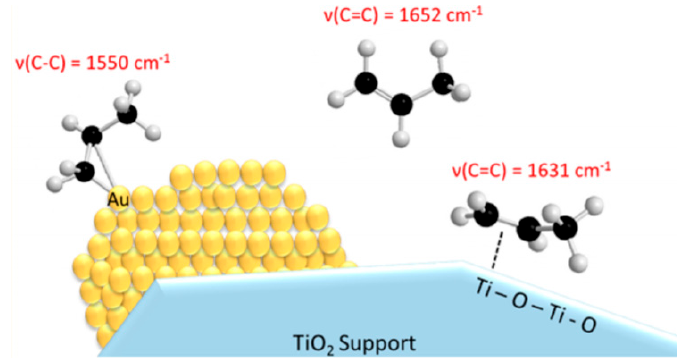
Figure 6. Adsorption structure and stretching frequencies of the C=C bond of propylene on Au/TiO 2 catalyst [111]. Copyright © 2017 American Chemical Society.